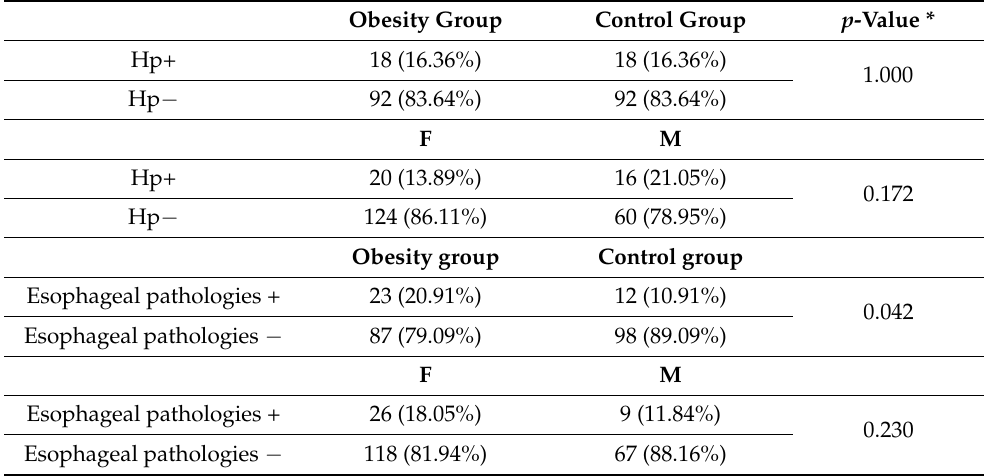
Table 5. Prevalence of gastrointestinal pathologies in obese group of patients and control group of patients and in women and